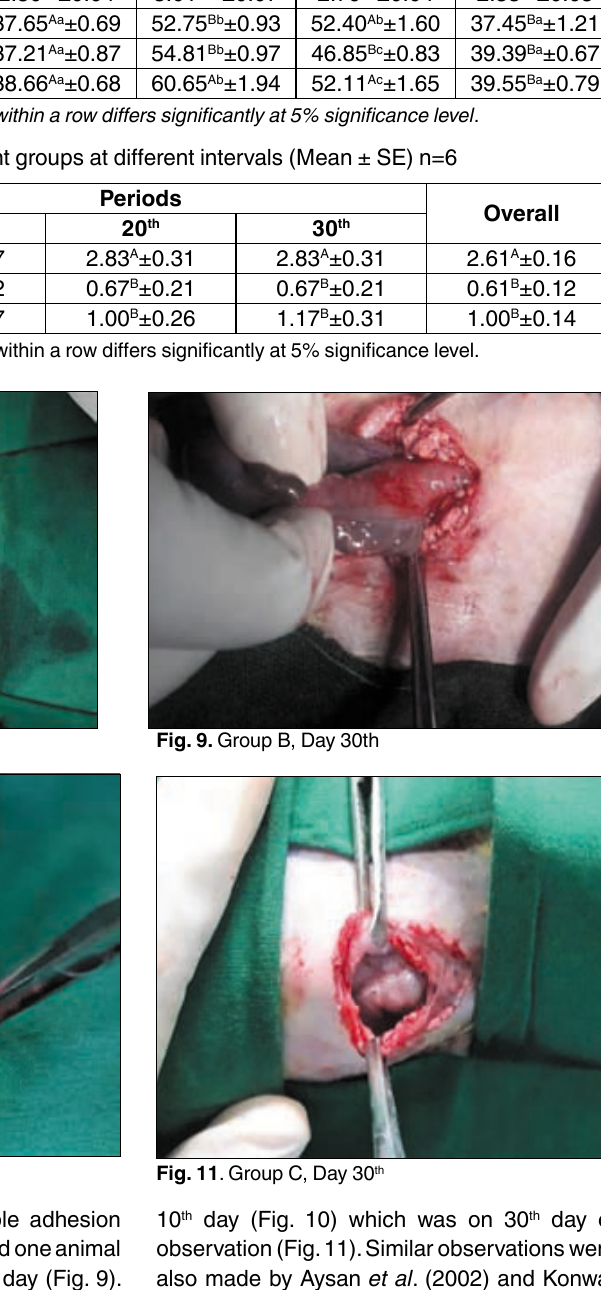
Table 2. Observations on biochemistry of peritoneal fluid (Mean ± SE) n=6 Biochemical Groups parameters